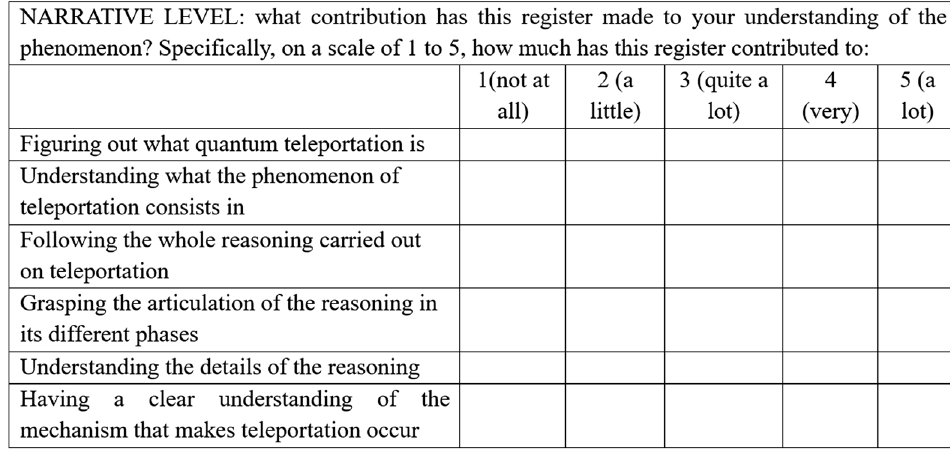
FIG. 28. About the narrative